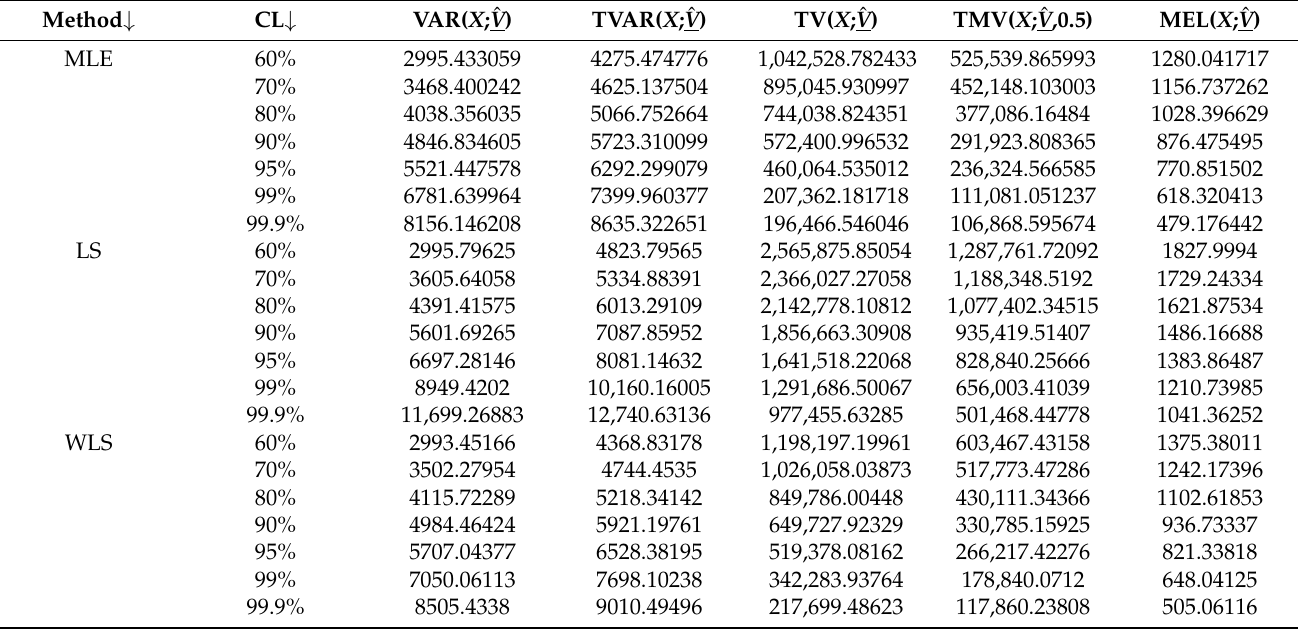
Table 5. The KRIs for the GRC under insurance claims